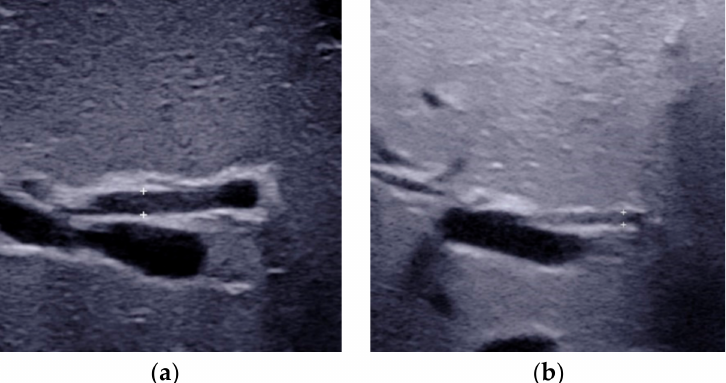
Figure 5. Hepatic artery measurement images of infants with ( a ) and without biliary atresia ( b ).